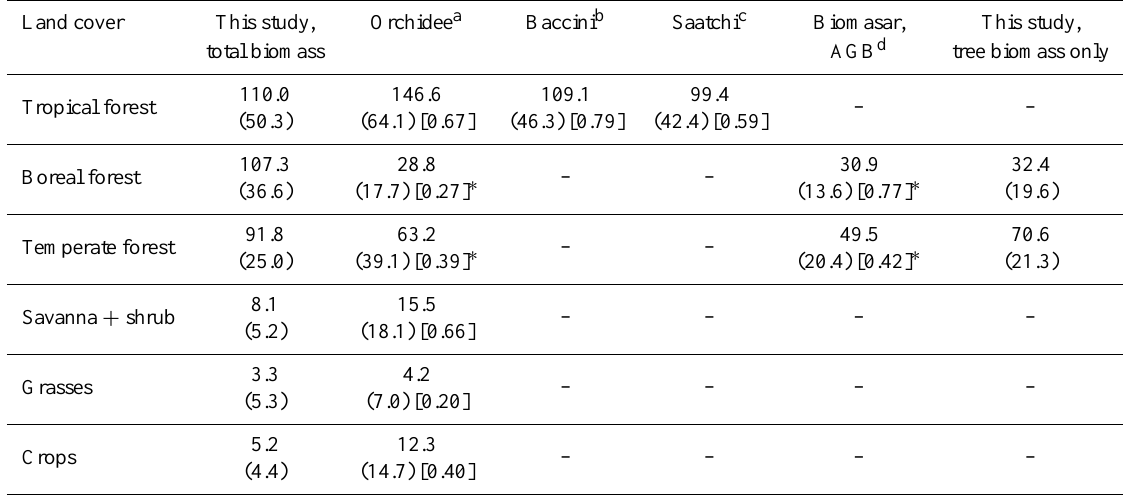
Table 2. Carbon biomass obtained as mean values of the 0.5 degree pixels with at least 80% of the land cover analyzed, in units of MgCha − 1 . Standard deviation values are shown in parenthesis. The values of the Spearman’s rho coefficient compared to the results from this study are shown in brackets ∗